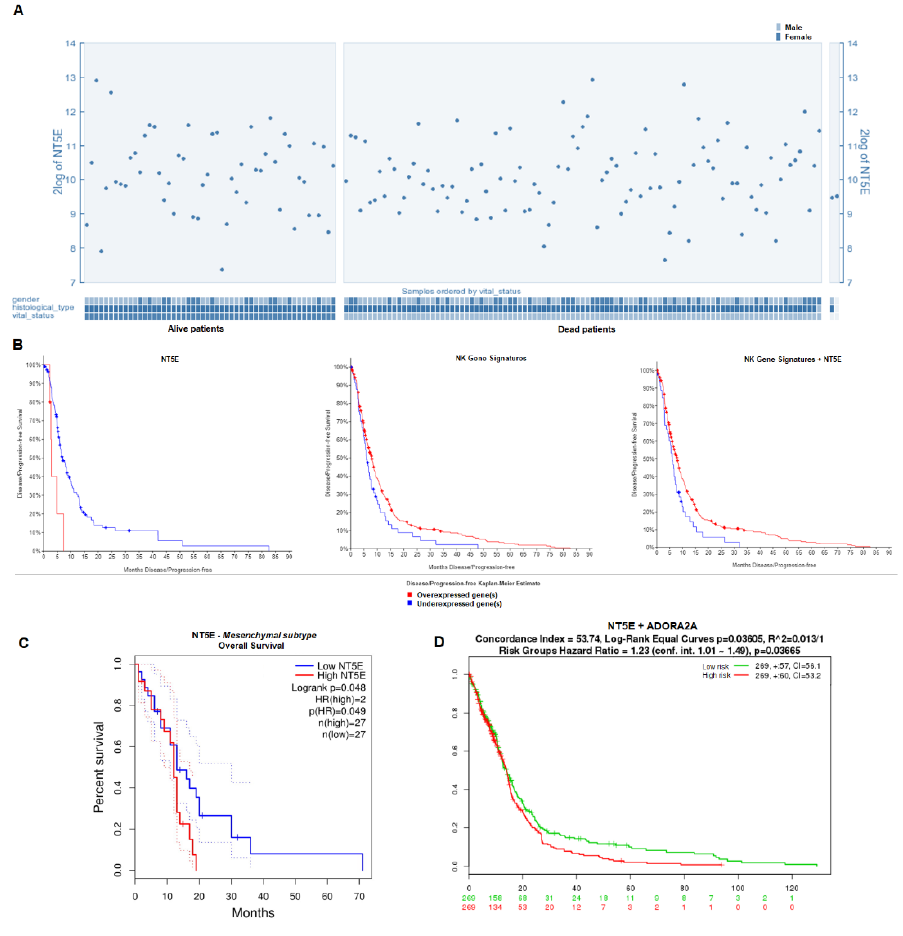
Figure 2. Survival analysis in the context of NT5E and natural killer (NK) gene signature expression. ( A ) Expression of NT5E in GBM patient samples plotted on the basis of patient vital status. Analysis was done in R2 ( n = 540). ( B ) Disease-free survival of GBM patients on the basis of NT5E expression level from TCGA RNASeq V2 RSEM data ( p = 0.0039; z = 2; left ; n = 166); NK gene signatures comprising 13 NK-specific genes from U133 A ff ymetrix gene expression data ( p = 0.0285; middle panel ); and both NT5E and NK gene signatures from U133 A ff ymetrix gene expression data ( p = 0.0109; right ). Kaplan–Meier plots were generated in cBioPortal ( n = 533). ( C ) Overall survival of GBM patients with the mesenchymal subtype based on NT5E expression. Analysis was done in GEPIA2 ( n = 163). ( D ) Overall survival stratified by risk group for patients expressing NT5E and ADORA2A . Analysis was done in